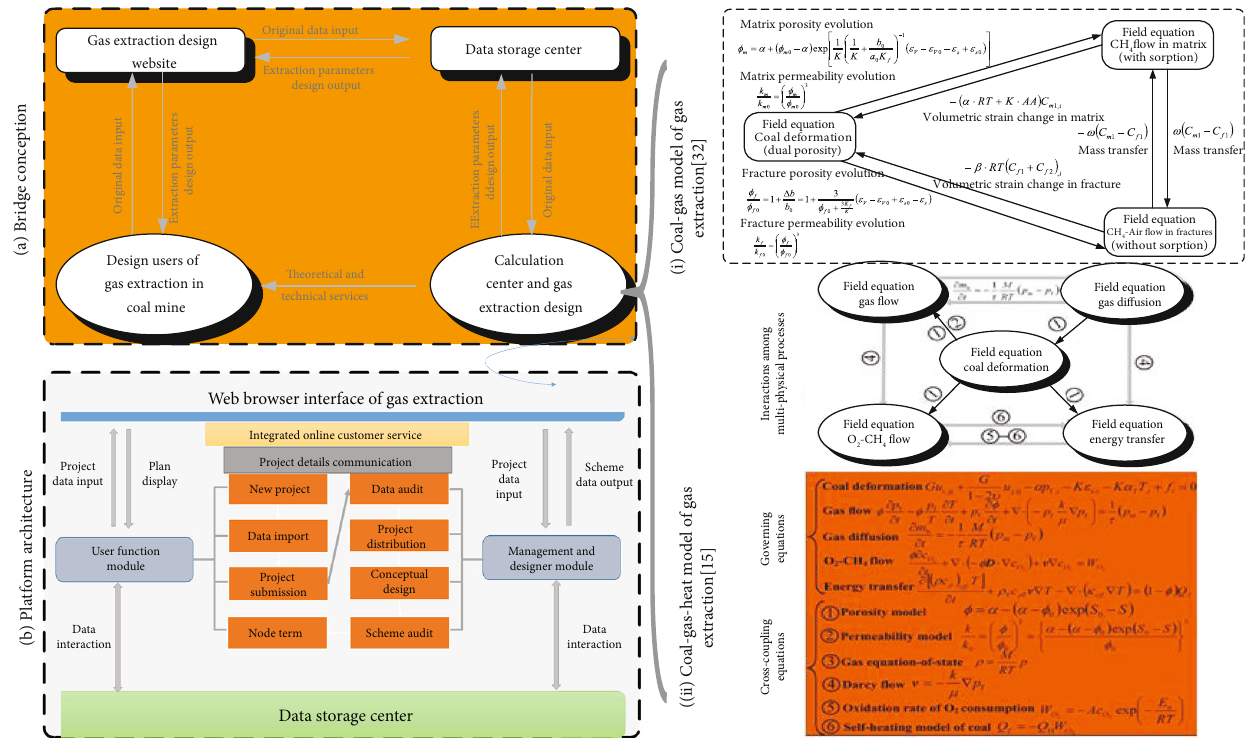
Figure 2: Idea architecture and calculation models of engineering design